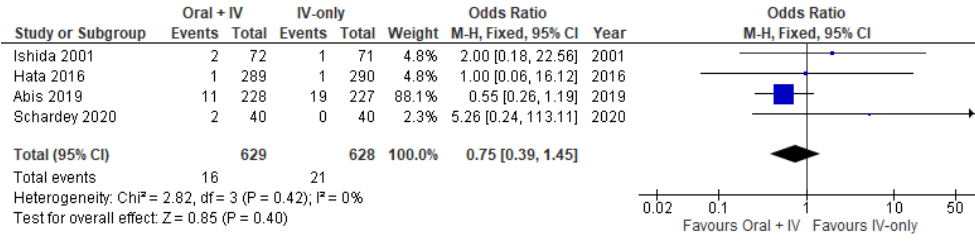
Figure 7. Forest plot of pneumonia comparing oral + IV group and IV-only group.